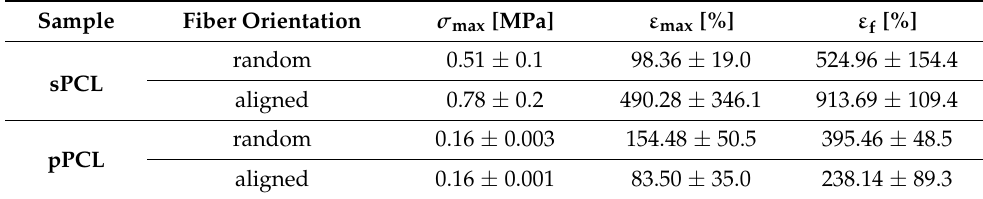
Figure 2. SEM micrographs of ( A , B ) smooth, ( C , D ) porous random and aligned polycaprolactone (PCL) fibers respectively, and ( E ) histogram of PCL fiber diameter distribution. Table 2. The average values from mechanical testing of the PCL fiber mats showing: σ max tensile strength, ε max strain at max strength, and ε f strain at